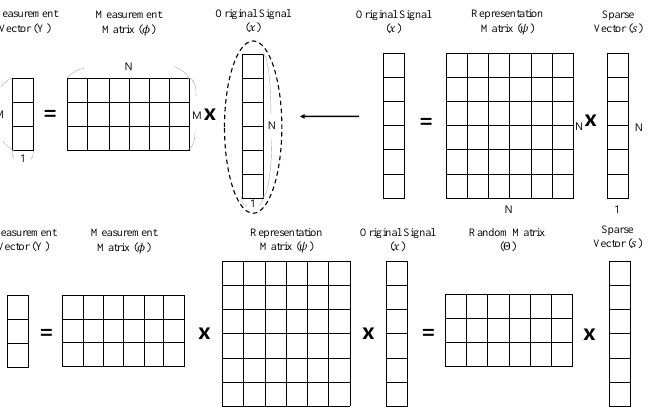
Figure 1. The reconstruction process of the interest signal x in compressed sensing. The purpose of reconstruction is to obtain a measurement vector Y using the measurement matrix and the original signal. Calculating the top of the figure at once can be explained as shown in the figure